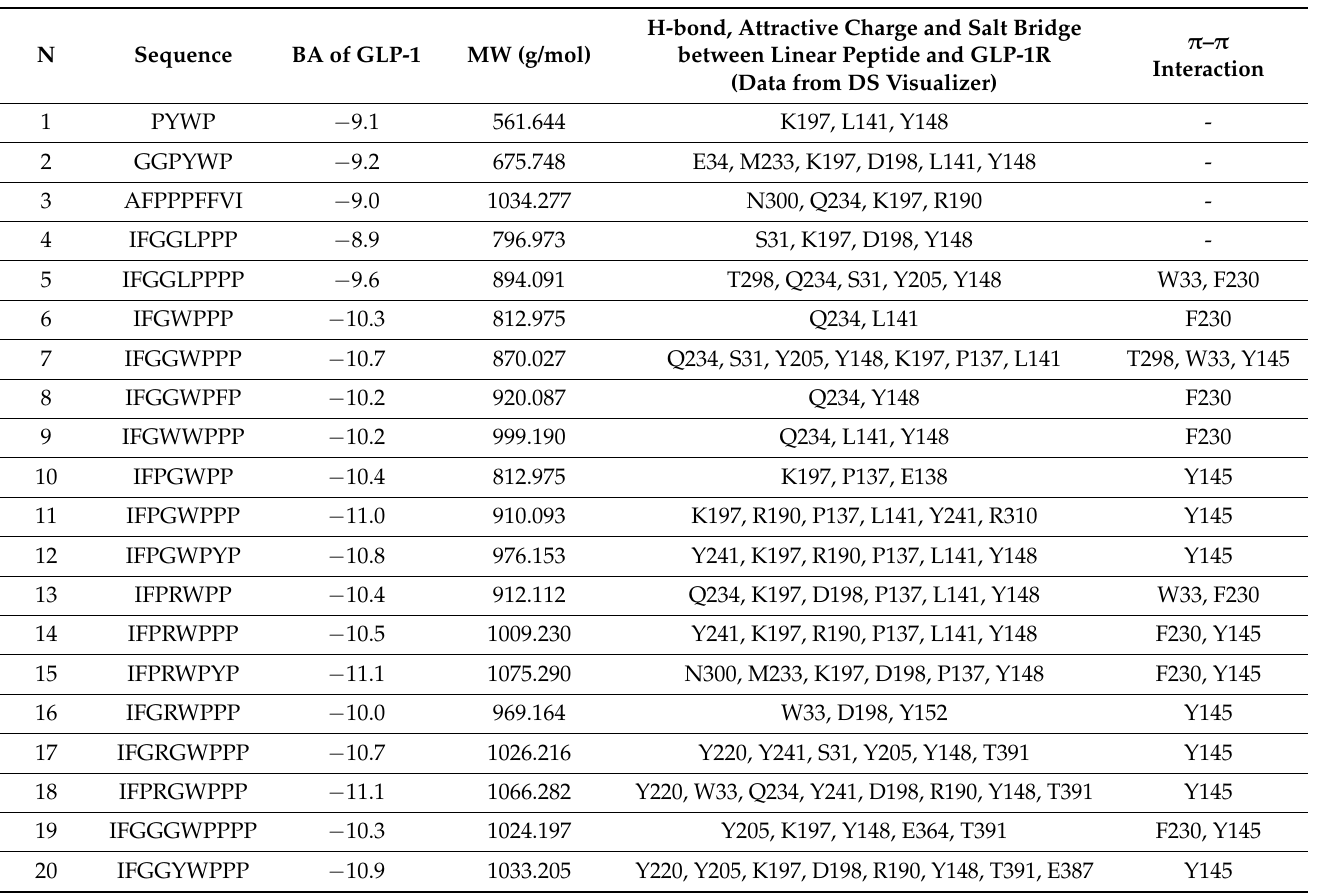
Table 3. Analysis table of docking linear peptide with